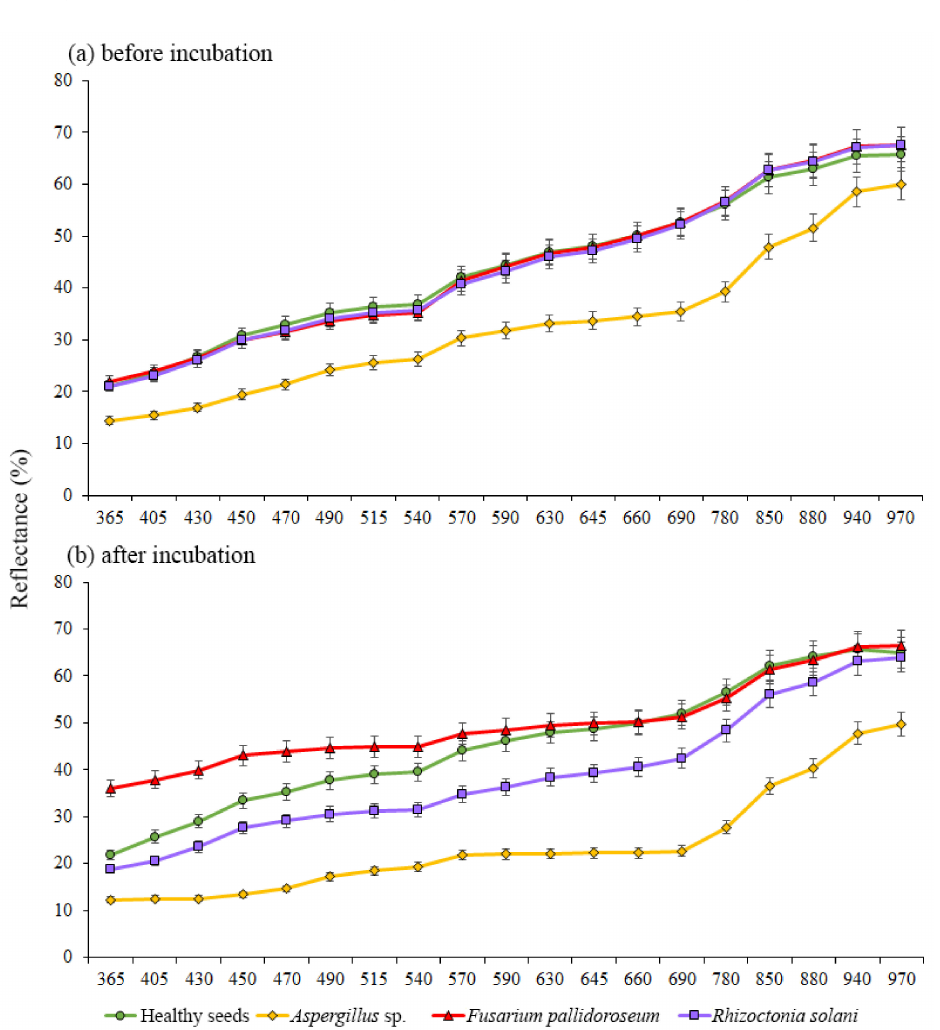
Figure 2. Spectral signature for classes of healthy seeds, Fusarium pallidoroseum, Rhizoctonia solani and Aspergillus sp. at 19 wavelengths in a range from 365 to 970 nm before incubation ( a ) and after incubation ( b